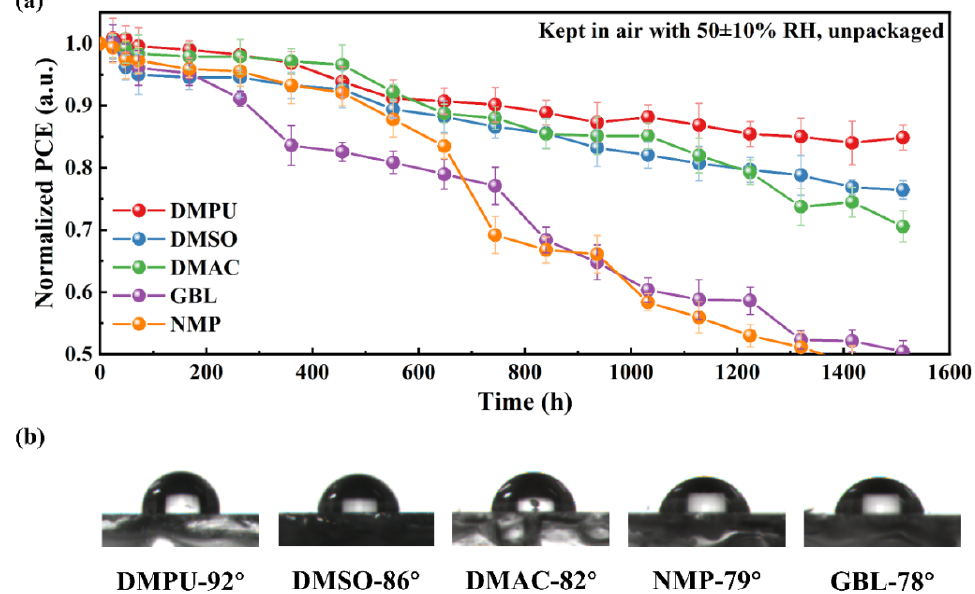
Figure 4. ( a ) PCE decay measurements based on unpackaged devices prepared by different solvents in air (average values were obtained based on 3 devices in each condition). ( b ) Snapshots of surface contact angle measurements for perovskite films prepared with different solvents.